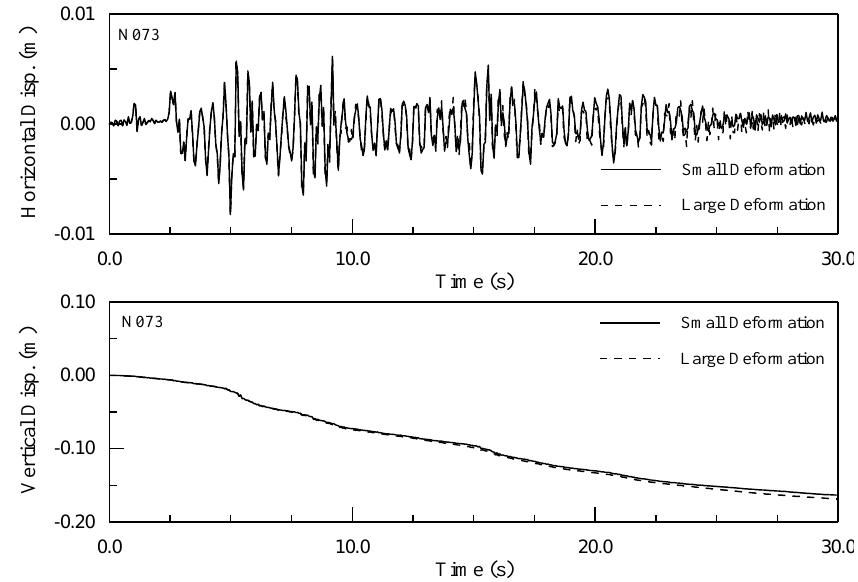
Figure 9. Horizontal and vertical displacement – time histories at node N073.